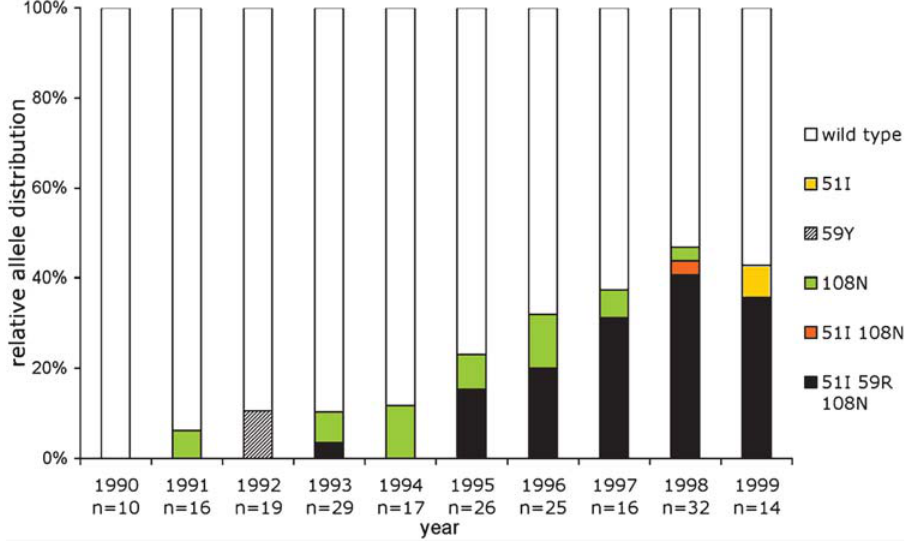
Figure 3. Temporal variation of the relative Pfdhfr-tsgene polymorphism in Dielmo during 1990–99. The 1.8 kb PCR fragment corresponding to the full length Pfdhfr-ts coding sequence was sequenced on both strands for a total of 204 isolates. The yearly distribution of the various genotypes is shown, using the colour code shown to the right of the figure. The alleles presenting synonymous mutations were omitted from the colour coding. The C59Y non-synonymous substitution was a TGT to TAT mutation. The synonymous mutations (CTA to TTA or CTC for codon 40, GGA to GGC for codon 241) are not depicted. No mutation was detected at codon 16 and 164, and no bolivia repeat type was observed. Overall there were 155 isolates with wild type coding sequence and 49 isolates with non synonymous mutations (76% and 24%, respectively). There were 15 (7.3%) single mutant s [51I (0.5%), 59Y (1%), 108N (5.8%)], one (0.5%) 51I 108N double mutant and 33 (16.2%) 51I 59R 108N triple